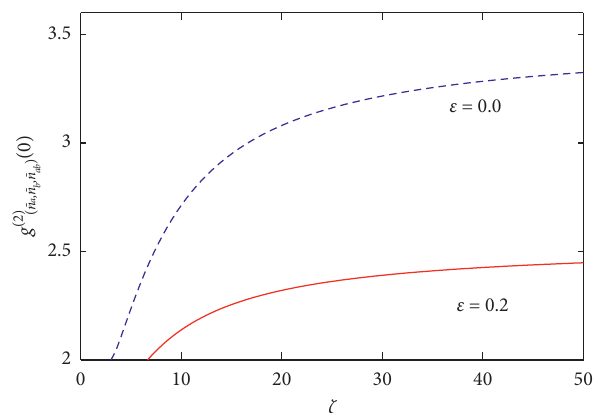
Figure 8: Plots of the steady state photon number correlation (equation (62)) versus ζ for κ � 0 . 8, r � 0 . 75, and A � 2 . 50 and for different values of ε .